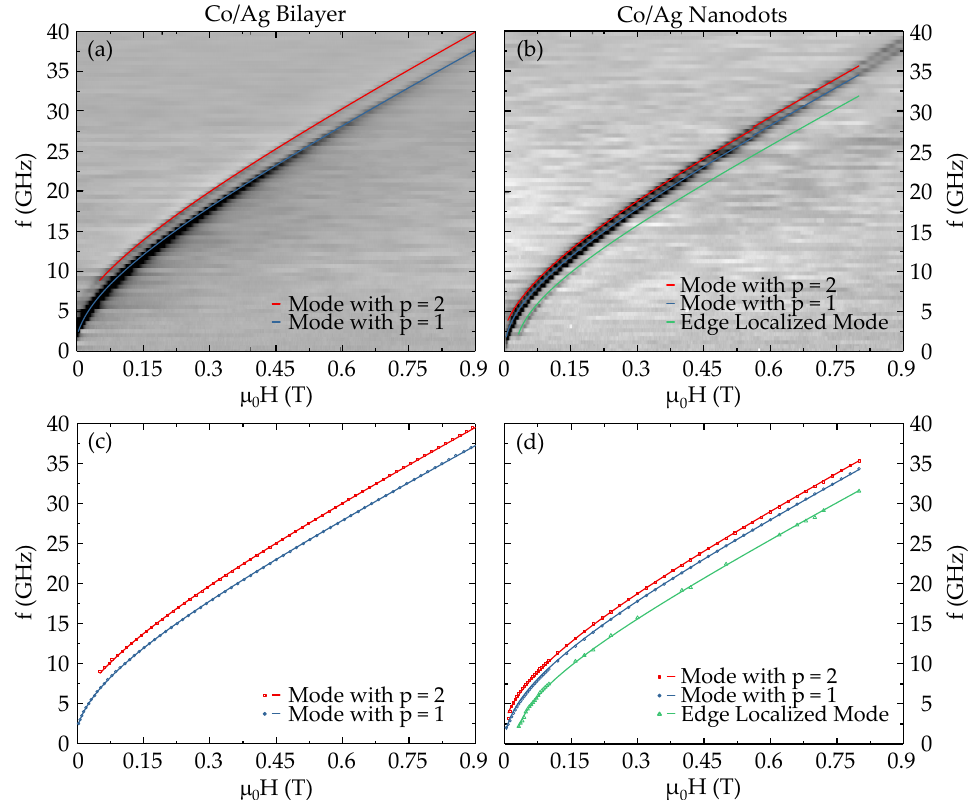
Figure 4. VNA-FMR spectra for the Co(50 nm)/Ag(30 nm) samples. Raw data for ( a ) the bilayer sample and ( b ) the nanostructured dots, extracted data and fits for ( c ) the bilayer sample and ( d ) the nanostructured dots. The solid lines are the fits obtained from Equation (23), using the wave vector profiles given in Equation